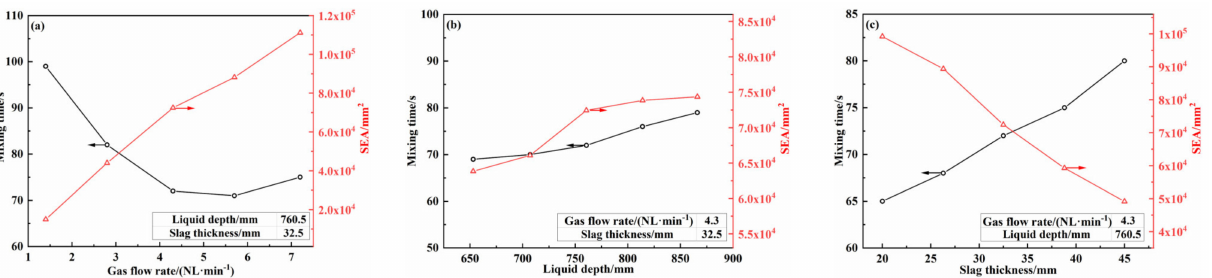
Figure 5. Effect of various factors on MT and SEA at: ( a ) gas flow rate; ( b ) liquid depth; ( c ) slag thickness.